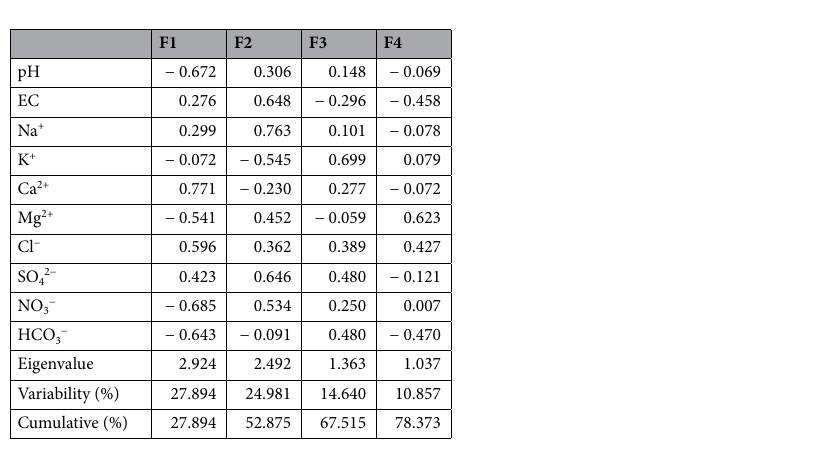
Table 1. Principal components (PCs) loading for selected physicochemical parameters in